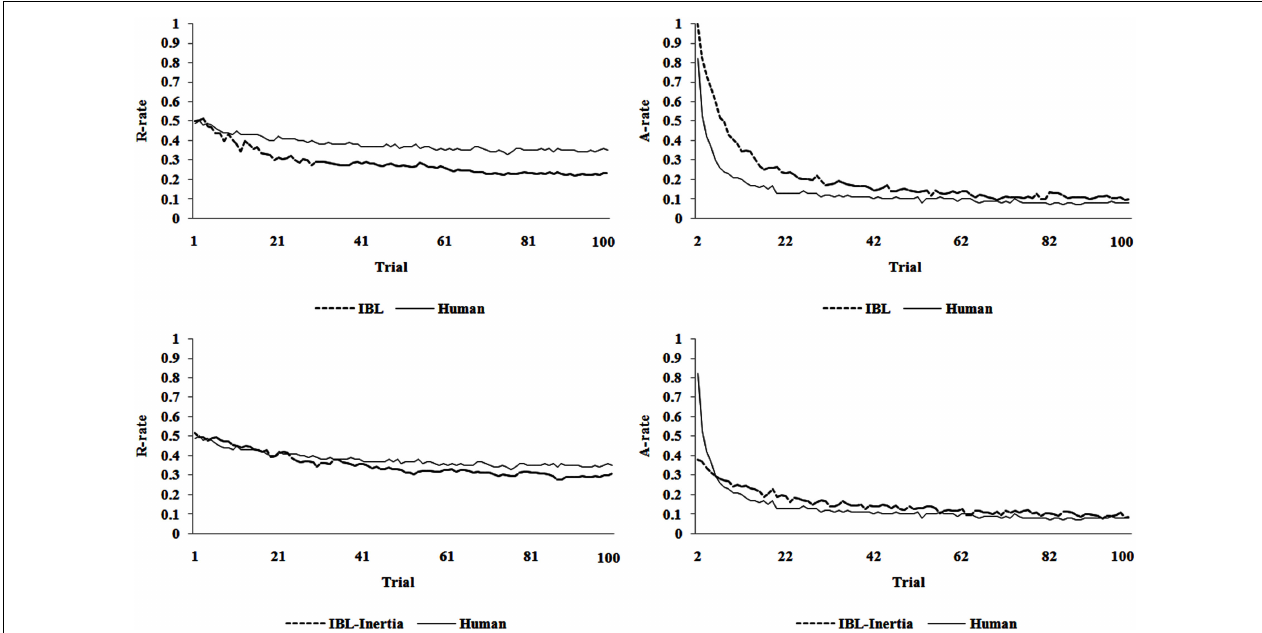
FIGURE 4 |The R-rate andA-rate over trials predicted by the IBL and IBL-Inertia models upon their generalization in the competition set. The R-rate and A-rate observed in human data in the competition set are also